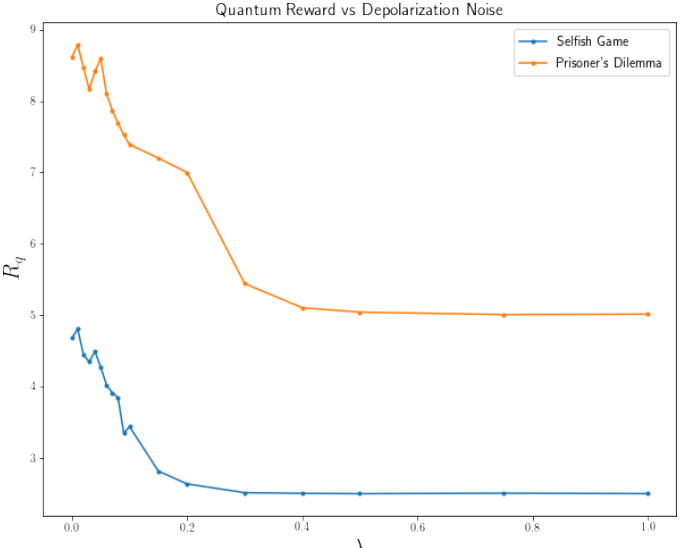
Figure 7. Reward of quantum players as a function of the λ parameter for the depolarizing chan- nel model.